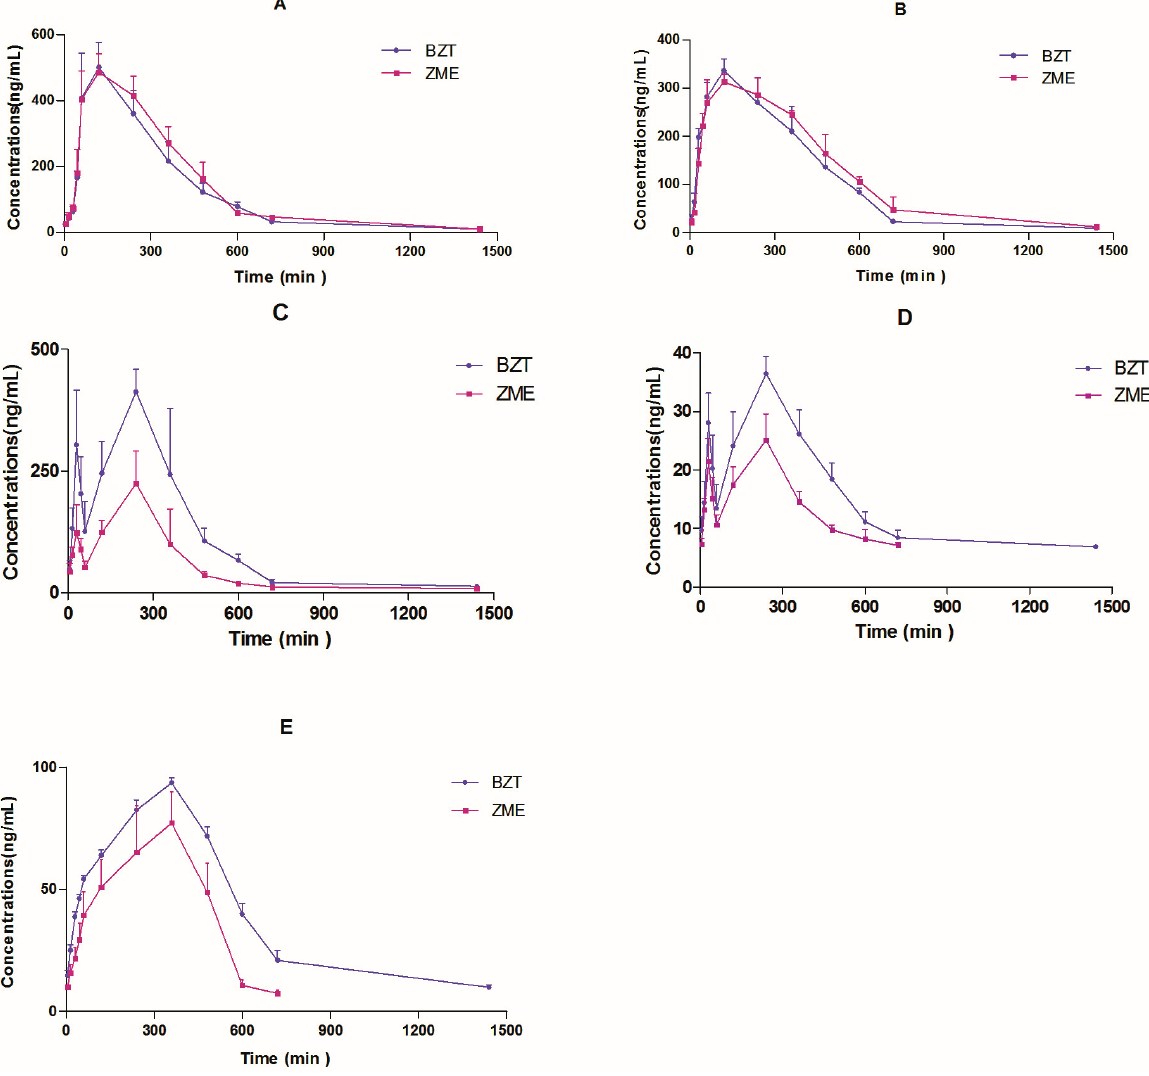
Figure 3. Mean concentration-time profiles of mangiferin ( A ), neomangiferin ( B ), timosaponin BII ( C ), anemarsaponin BIII ( D ) and timosaponin AIII ( E ) in rat plasma after oral administration of BZT and ZME. Each point represents the mean ± SD (n =